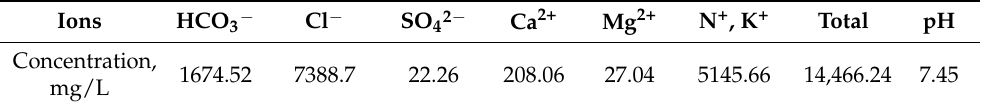
Table 1. The formula of the simulation formation of